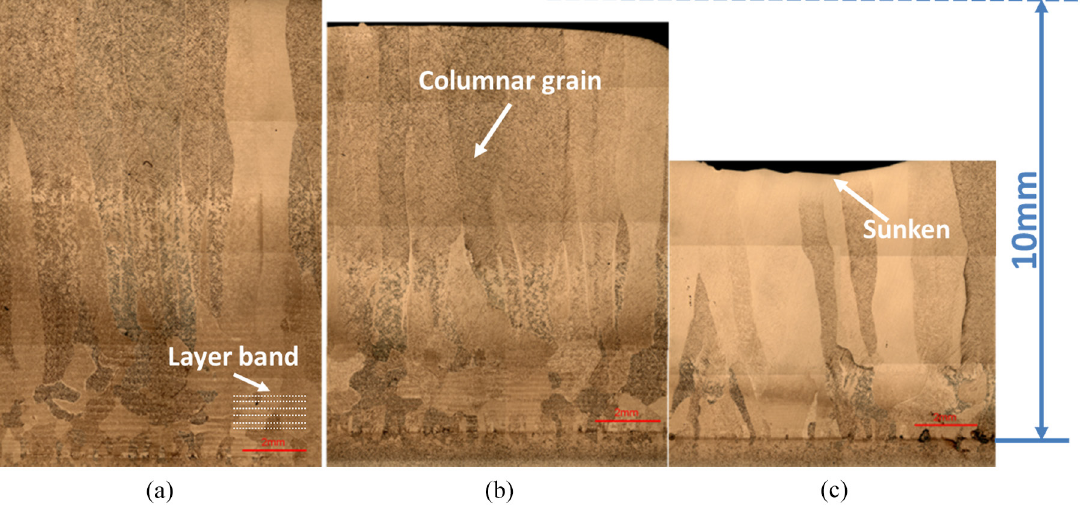
Figure 3. Montage of macrostructure of pulse laser deposition Ti6Al4V thin wall showing large columnar growth prior β grains with scanning speed of 600 mm/min (a); 800 mm/min (b); 1200 mm/min (c). (Frequency is 500 HZ, laser power is 923 W, and average laser power is 600